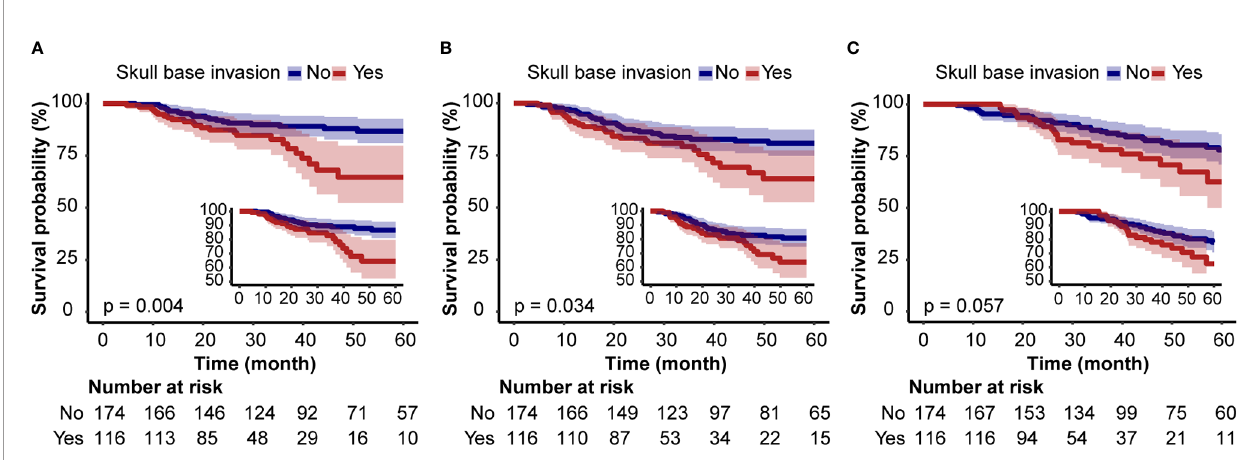
FIGURE 2 | Kaplan – Meier Survival Curves for bone metastasis-free survival (A) , distant metastasis-free survival, (B) and overall survival (C) of locally advanced nasopharyngeal carcinoma patients based on skull base invasion.